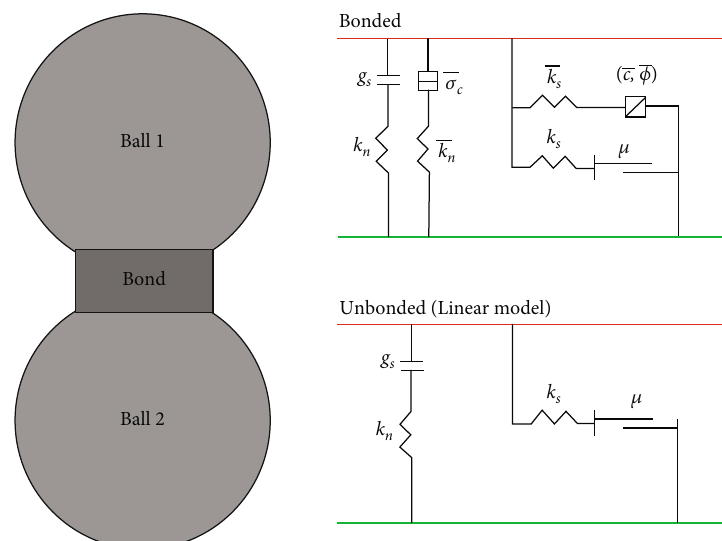
Figure 9: The parallel bond model [24].